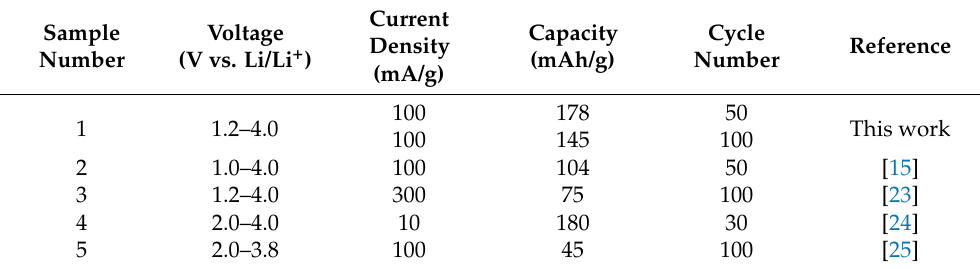
Table 2. Comparisons of the electrochemical performances of the present FeOF with related represen- tative FeOF cathode materials for LIBs reported in the